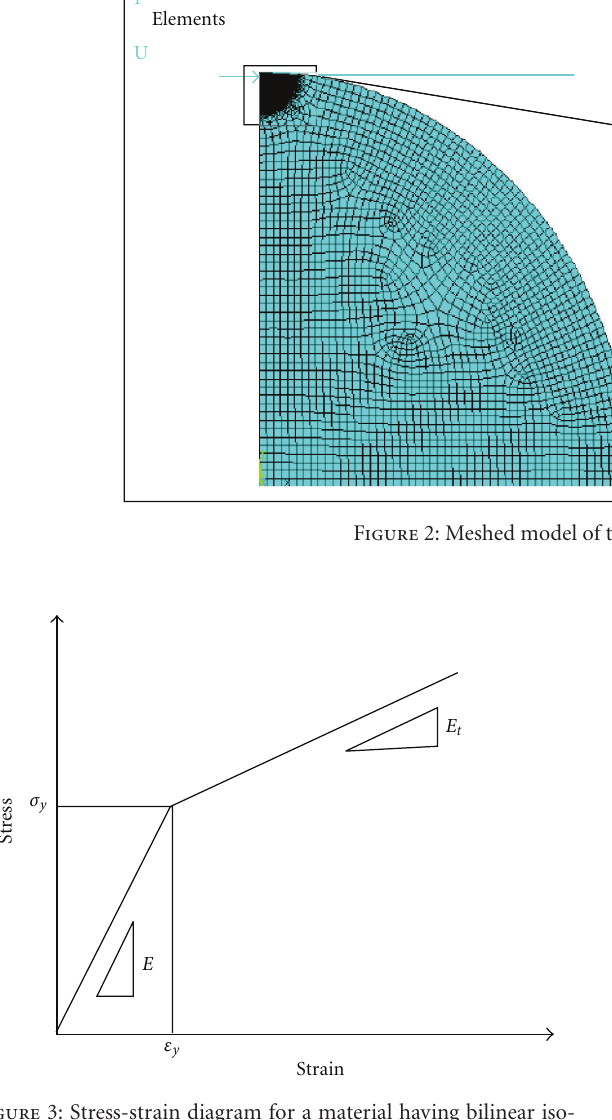
Figure 3: Stress-strain diagram for a material having bilinear iso- tropic properties.